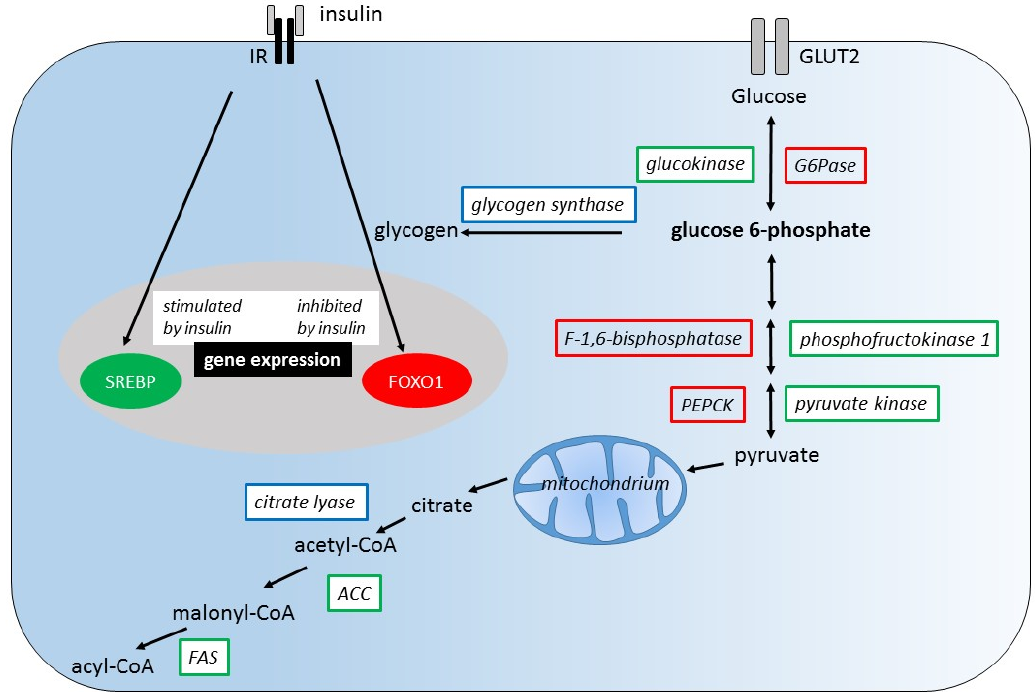
Figure 1. Regulation of liver metabolism by insulin. Insulin stimulates the expression of genes encoding glycolytic and lipogenic enzymes (green), but inhibits the expression of those encoding gluconeogenic enzymes (red). The induction of gene expression by insulin is mediated by the transcription factor sterol regulatory element binding protein (SREBP), the repression of expression is mediated by forkhead box O1 (FOXO1). Insulin also regulates the activity of glycogen synthase and citrate lyase (blue). Insulin activates glycogen synthase promoting its dephosphorylation through inhibition of protein kinase A (PKA) and glycogen-synthase-kinase-3 (GSK-3). IR, insulin receptor; GLUT2, glucose transporter 2; PEPCK, phosphoenolpyruvate carboxykinase; ACC, acetyl-CoA carboxylase; FAS, fatty acid synthase (Adapted from [51]).